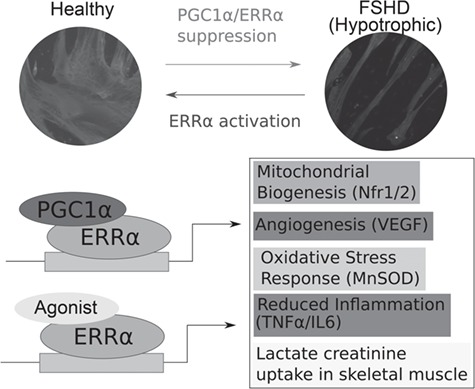
Suppression of PGC1α/ERRα expression in FSHD and rescue by ERRα agonists. Schematic summarising that PGC1α/ERRα suppression in FSHD drives an FSHD hypotrophic phenotype that can be rescued by ERRα agonists biochanin A, daidzein or genistein. Suppression of the ERRα/PGC1α pathway in FSHD patients could also contribute to know features of FSHD pathology including oxidative stress sensitivity, aberrant vasculature and inflammation.